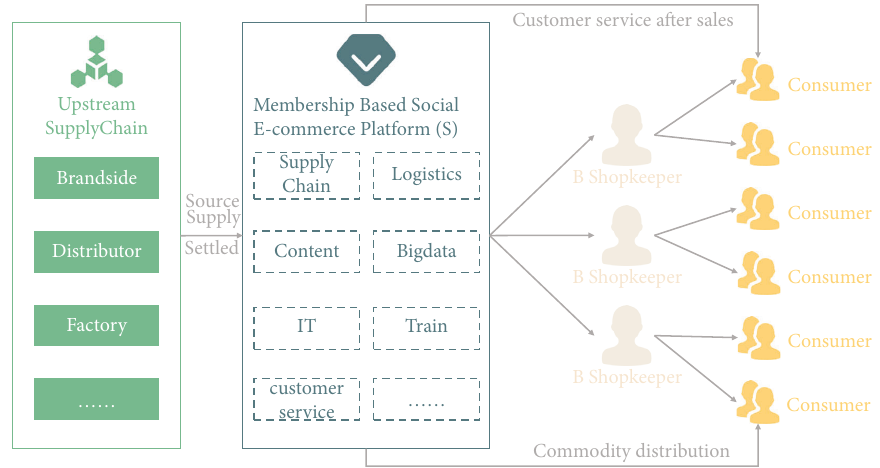
Figure 1: WeChat operation flow